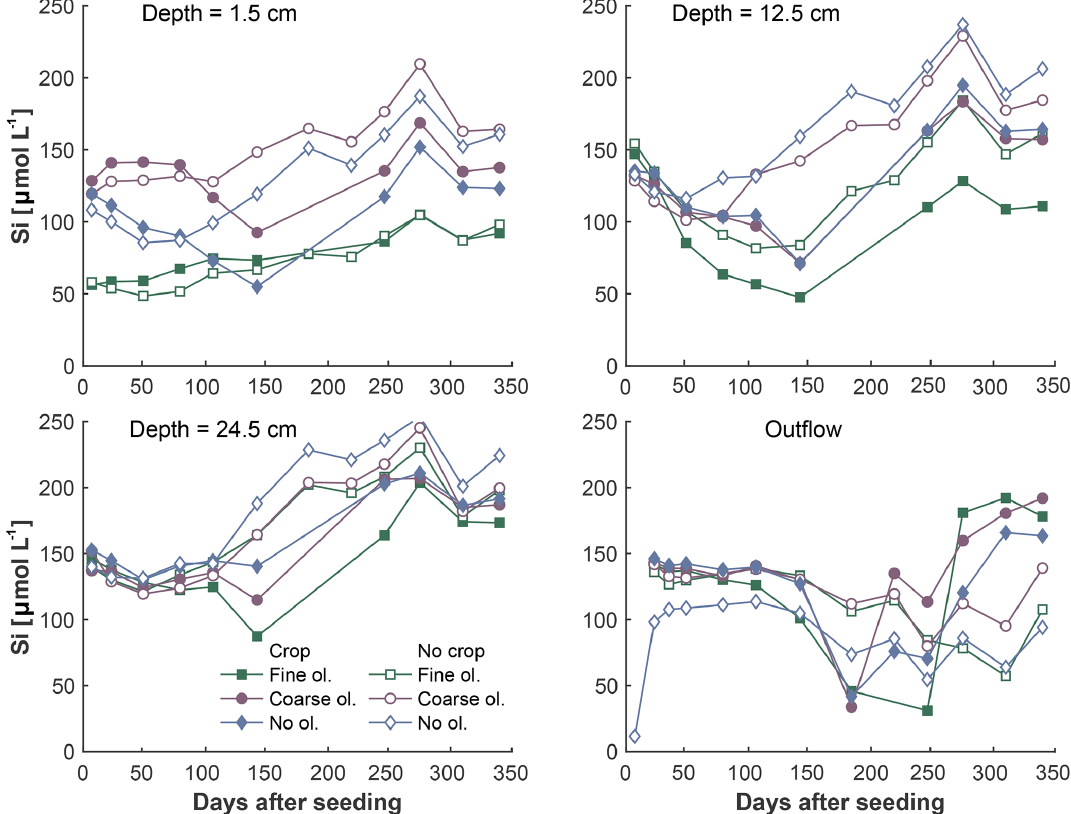
Figure 6. Development of Si concentrations over the experiment period in the surface layer, differentiated by olivine and crop treatment. Data points are averages, but error indicators were omitted to provide a better overview. For a more differentiated view and standard deviations, please refer to Fig. S6-1. Table 3. Mg and water flux averages ( ± SD) throughout the period of the experiment, excluding background contributions from soil and irrigation water, for crop and no crop treatment. The potential of Mg removal and its effect on CO 2 consumption is provided, assuming that all water would percolate the pore space of the upper soil and equilibrate towards the measured Mg concentrations. Details on the calculation of CO 2 consumption are found in Sect.